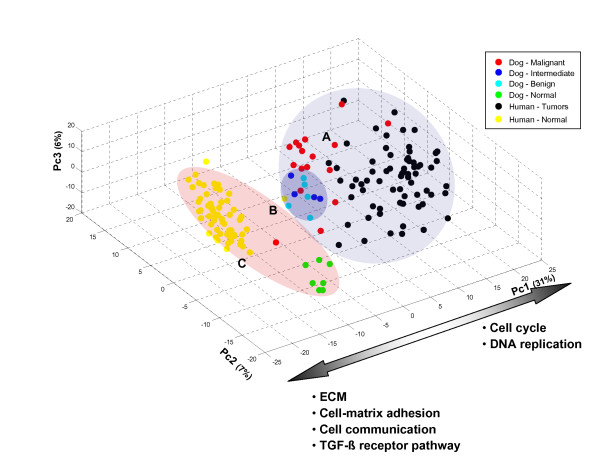
Principal component analysis of human-dog combined dataset. Results of principal component analysis based on the subset of 9,963 human-dog orthologous genes. The 162 samples were projected on the first three principal components that capture ~44% of the total variability. Three main sample clusters are highlighted in colors. Cluster A contains the majority of human and dog tumors. Cluster B is a sub-cluster of cluster A and contains mostly 'benign' and 'intermediate' dog tumors. Cluster C includes almost all normal samples from human and dog. The genes contributing the most to the first principal component analysis were analyzed by genes set enrichment analysis and enriched gene sets (p < 0.05) were selected. Results are summarized along the grey arrow. Among the others, cell cycle (P = 6e-9) and DNA replication (P = 7e-6) emerged as enriched gene sets (up-regulated in both species tumors and listed on the right side of the arrow), as well as extracellular matrix (P = 0.0025), cell matrix adhesion (P = 0.0078), cell communication (P = 0.0207), TGF-β receptor signaling pathway (P = 0.0115) (down-regulated in both species tumors and listed on the left side of the arrow).